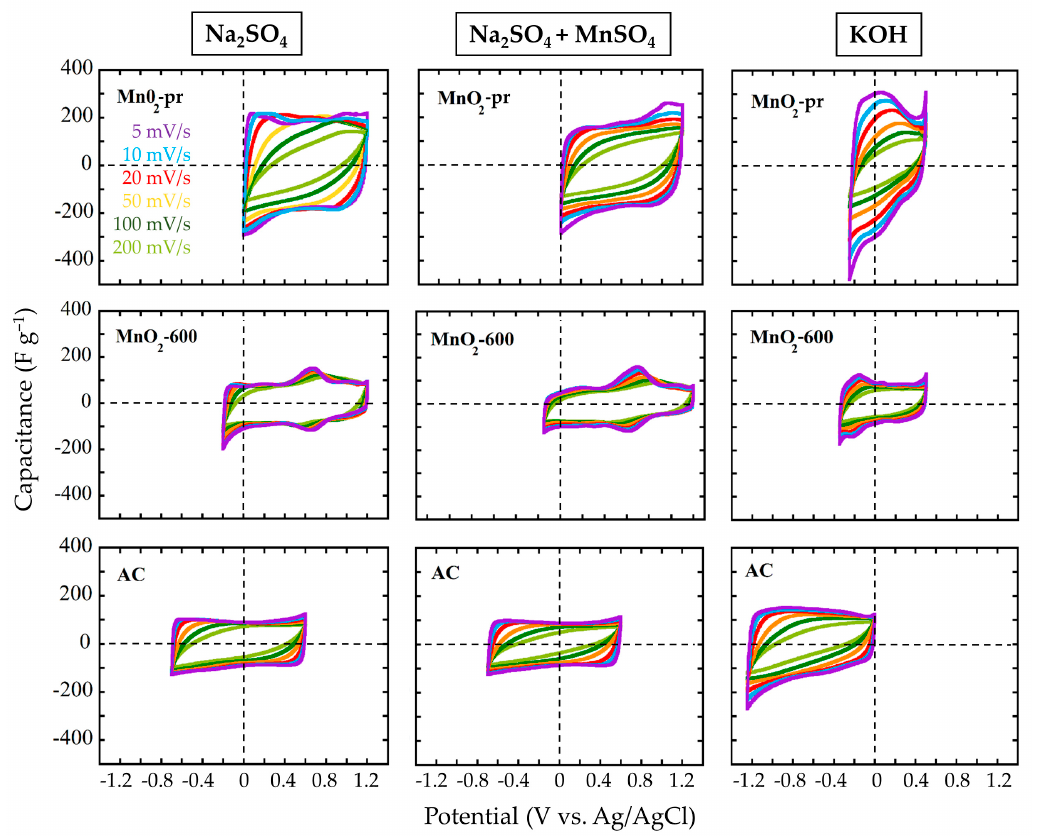
Figure 5. Cyclic voltammograms of manganese dioxide samples and AC electrodes in 0.5 M Na 2 SO 4 (Na 2 SO 4 ), 1 M KOH (KOH) and 0.5 M Na 2 SO 4 + 0.2 mM MnSO 4 (Na 2 SO4 + MnSO 4 ) electrolytes.